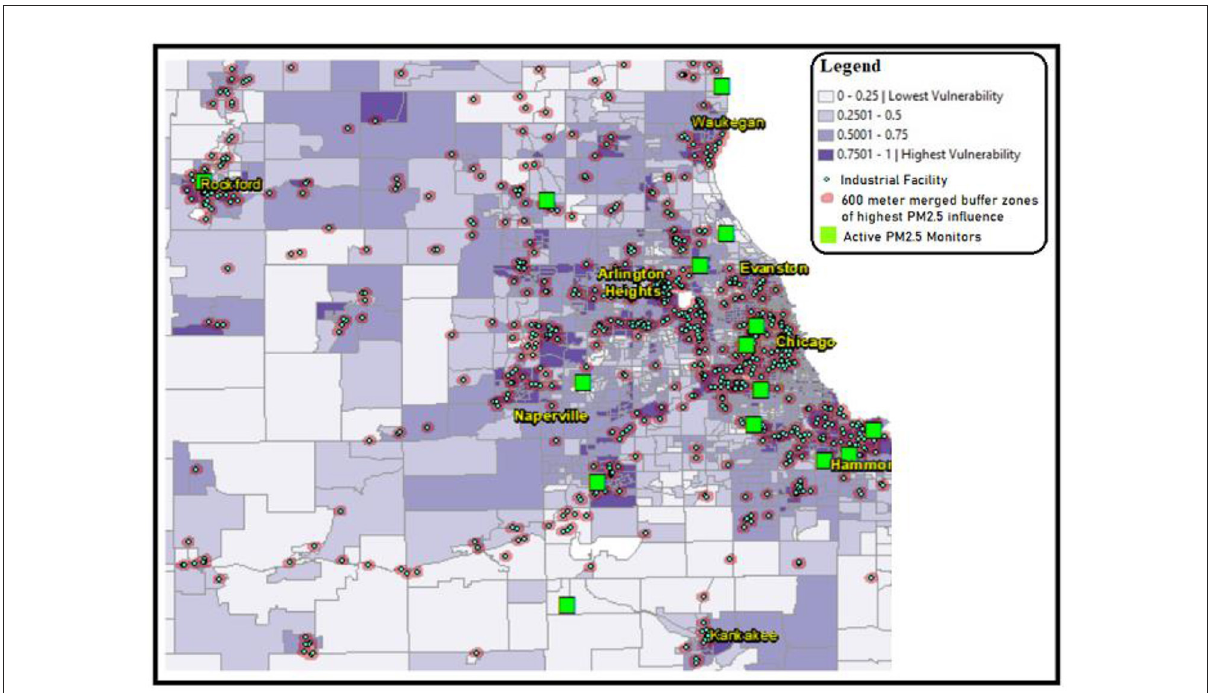
FIGURE3 CDC census tract SVI scores represented in shades of purple, overlaid with industrial facility locations represented with turquois diamonds. This map shows a prevalence of industrial facility sites located in areas of high SVI scores. The green squares indicate the locations of the EPA active PM2.5 monitors as of 2020. The red areas indicate the EPA radius of PM2.5 pollution influence (12). Authors recommend additional PM2.5 monitors for areas that represent with a confluence of high SVI scores (purple), PM2.5 radius of influence, and lack of centrally